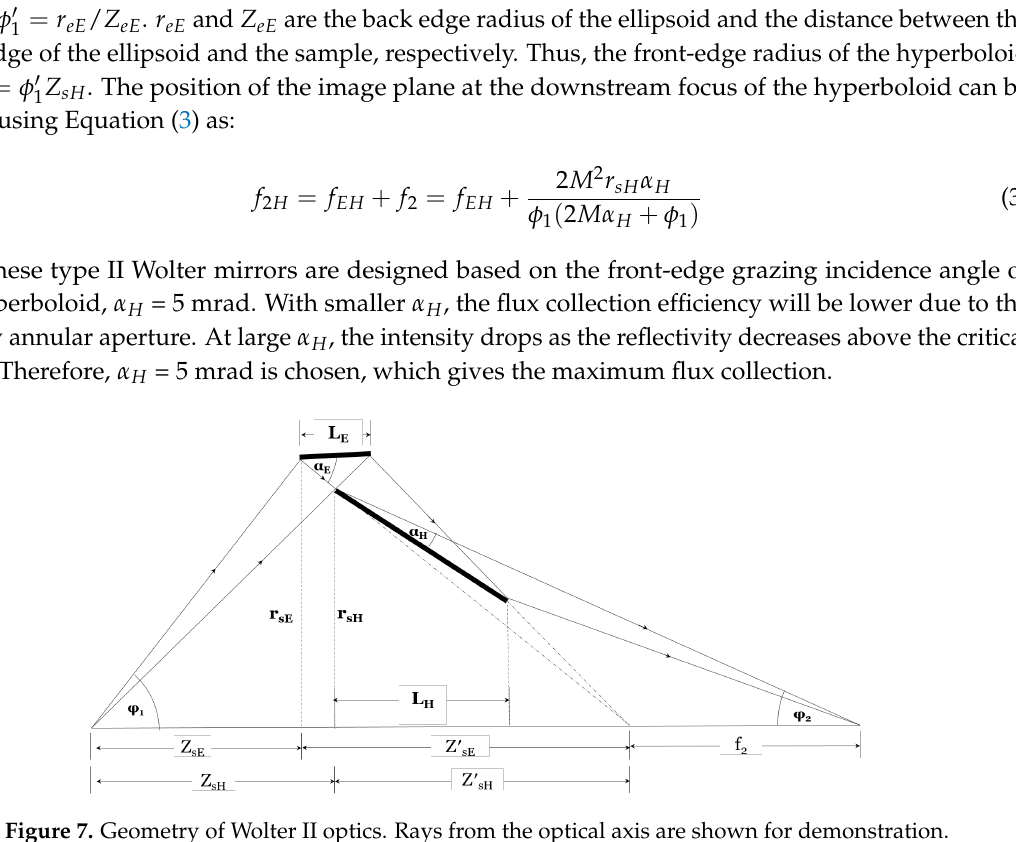
Figure 7. Geometry of Wolter II optics. Rays from the optical axis are shown for demonstration.